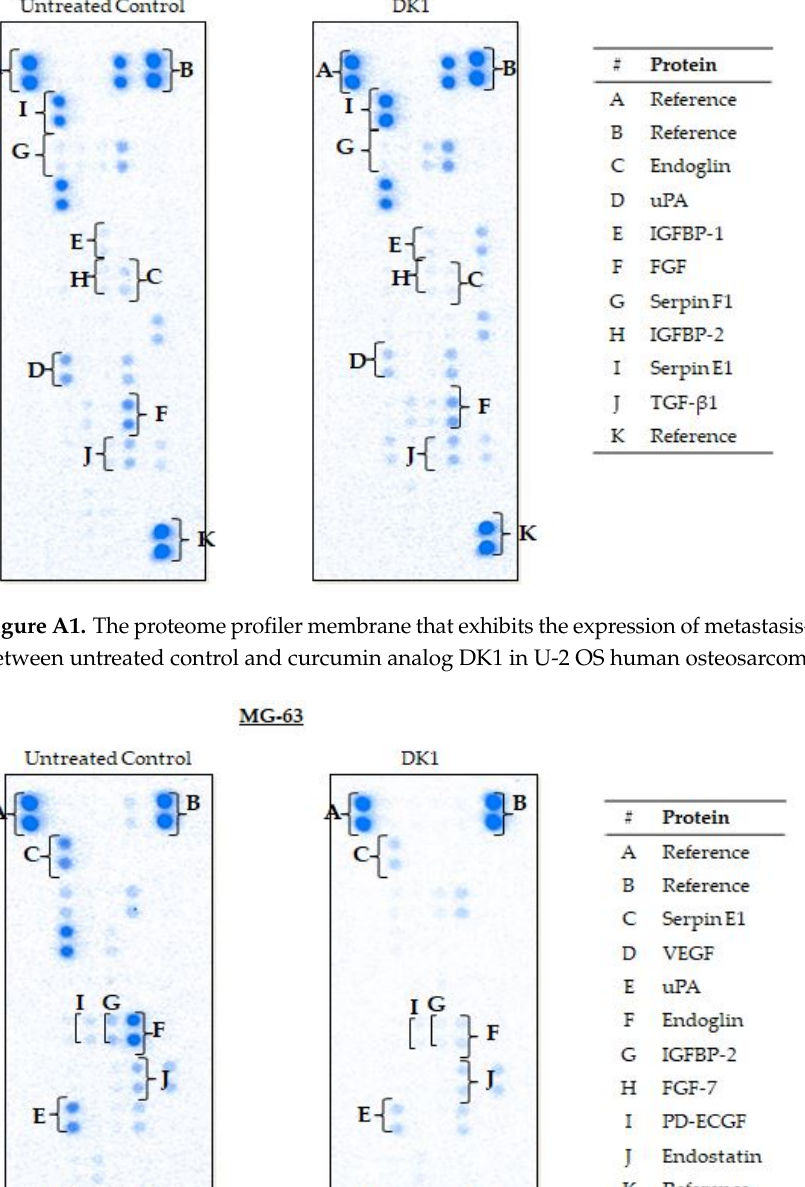
Figure A2. The proteome profiler membrane that manifests the expression of metastasis-related